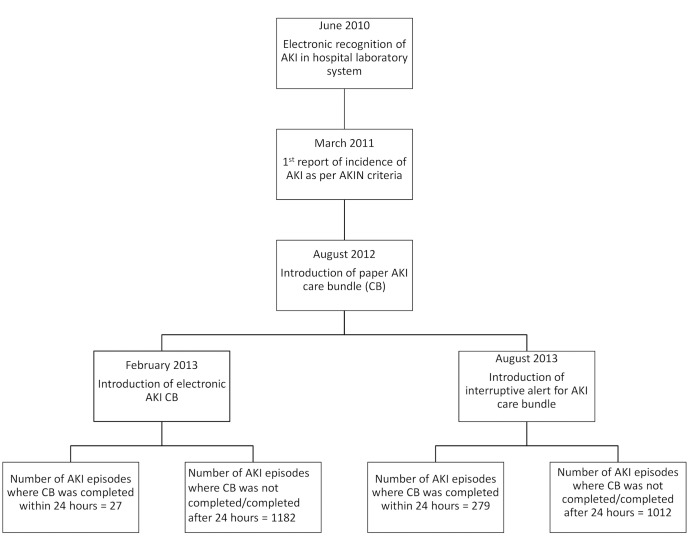
Study flow chart.